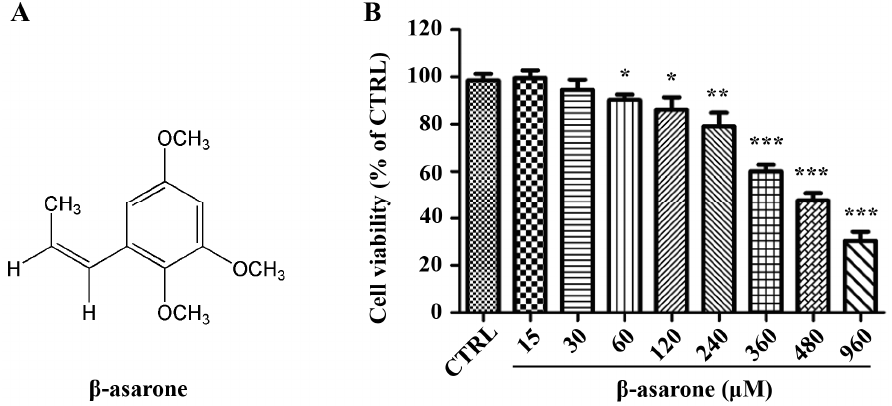
Figure 1. Cytotoxicity of β -asarone to U251 cells. ( A ) Chemical structure of β -asarone; ( B ) Cells were treated with β -asarone as indicated for 48 h, and cell viability was determined by sulforhodamine B assay and expressed as a percentage of that of the untreated cells. Values represent mean ± SD. * p < 0.05, ** p < 0.01 and *** p < 0.001 compared with vehicle .